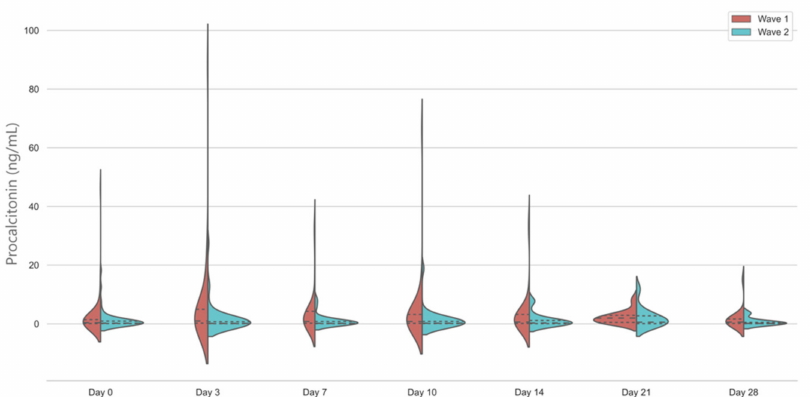
Figure 3. Temporal changes in procalcitonin levels in the first and second wave. Violin plots represent the distribution of data. Dashed lines show medians and interquartile ranges. The general linear model indicates significant differences between days in wave 1 and between groups, p < 0.001.